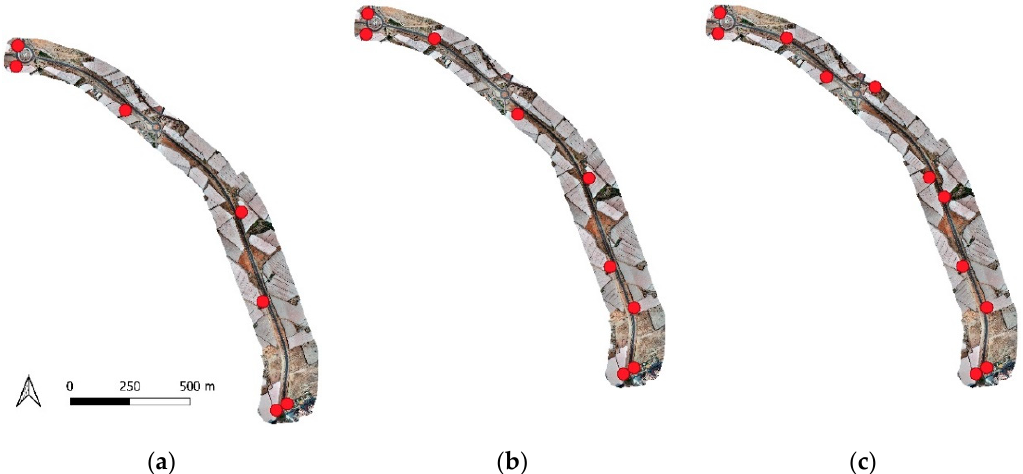
Figure 7. Location of the targets used as GCPs for each project within Distribution 3. Three projects using ( a ) 3, ( b ) 5, and ( c ) 9 GCPs.